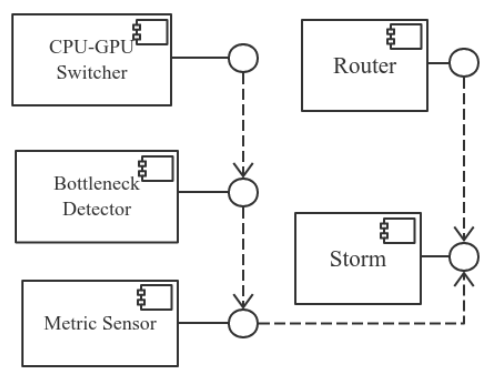
Figure 3. Healthcare4VideoStorm architecture illustrated as a component-connector